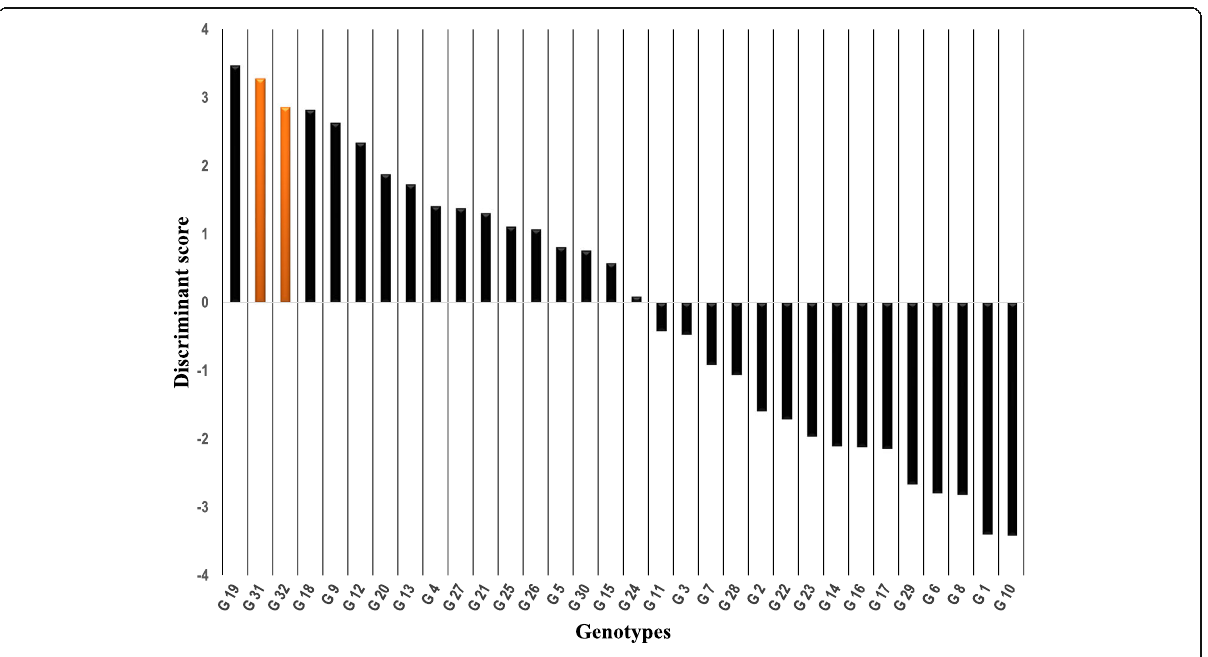
Fig. 2 Ranking genotypes based on discriminant